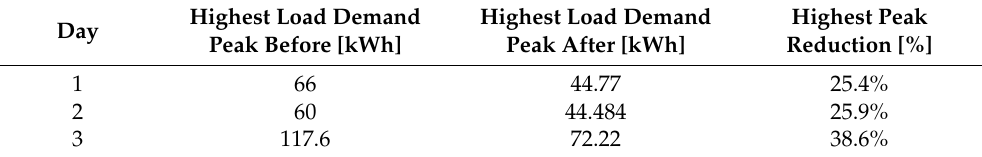
Figure 10. Load demand and PV profile, charge and discharge behavior of the BESS as well as SOC during a day, and a power profile comparison before and after peak shaving operation (the 9th of March). Table 9. The highest load demand peak before and after the peak shaving operation from the three chosen days in the testing data set. Table 8. RMSE , E b-disch , and P d-lim for the three days using predicted data. Day